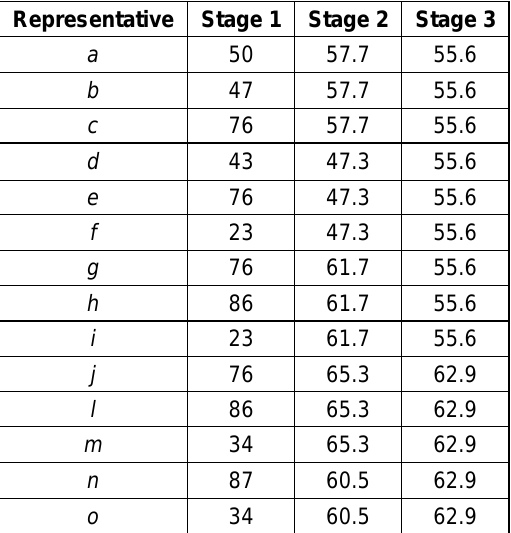
TABLE I. P ROCESSOR A VAILABILITY I